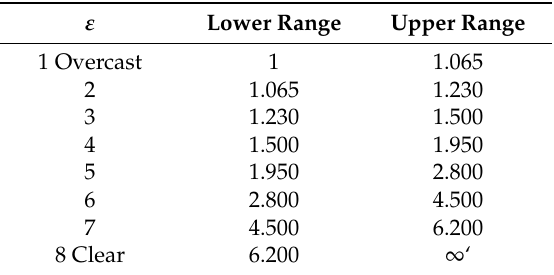
Table 4. Discrete sky clearness categories [60].